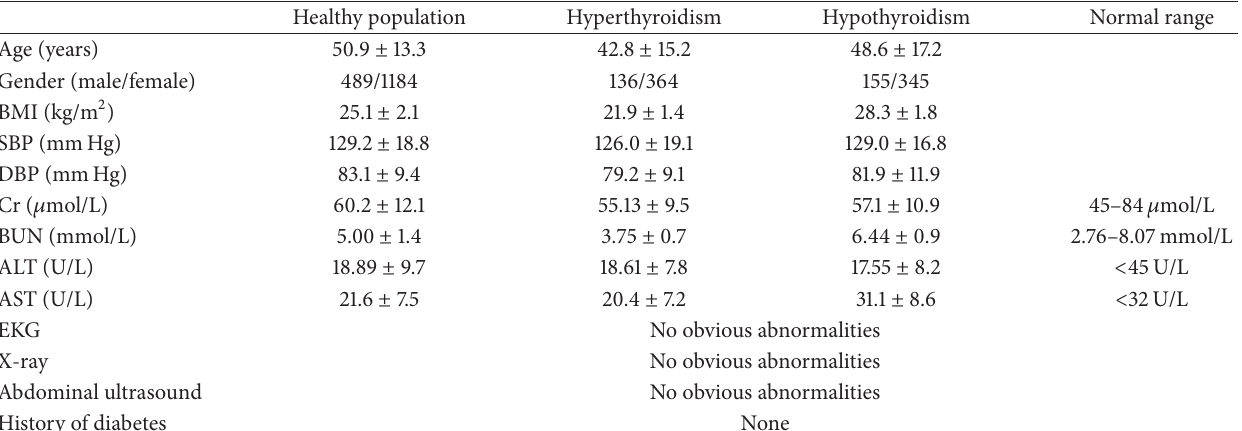
Table 1: Basic information.